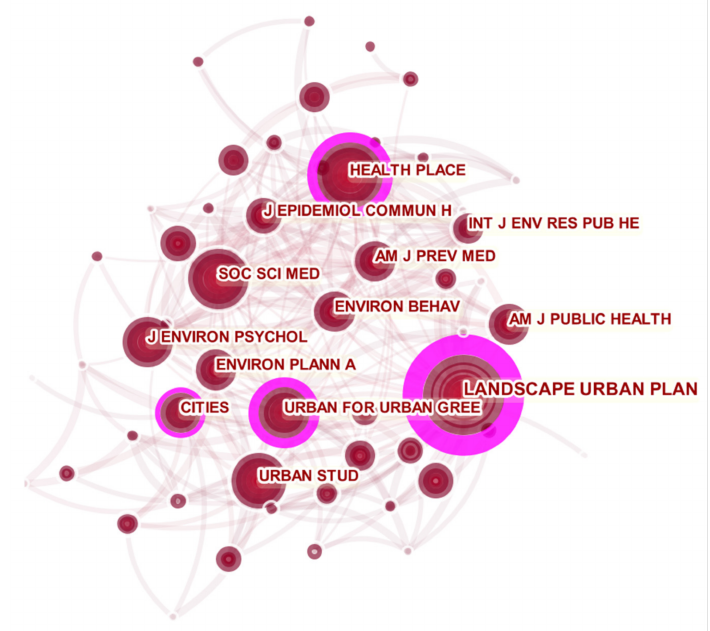
Figure 10. Visualization map of co-citation journal in healthy urban planning